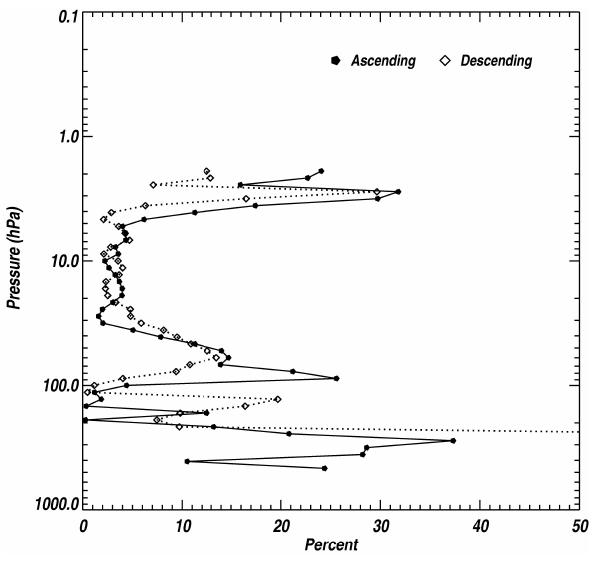
Fig. 4. Estimates of precision based on the minimum standard devi- ations (SD) of the retrieved LIMS V6 HNO 3 profiles from the sets of ascending (solid) or descending (dashed) orbital crossings of the latitude band of 25 ◦ S and 35 ◦ S on 1 February